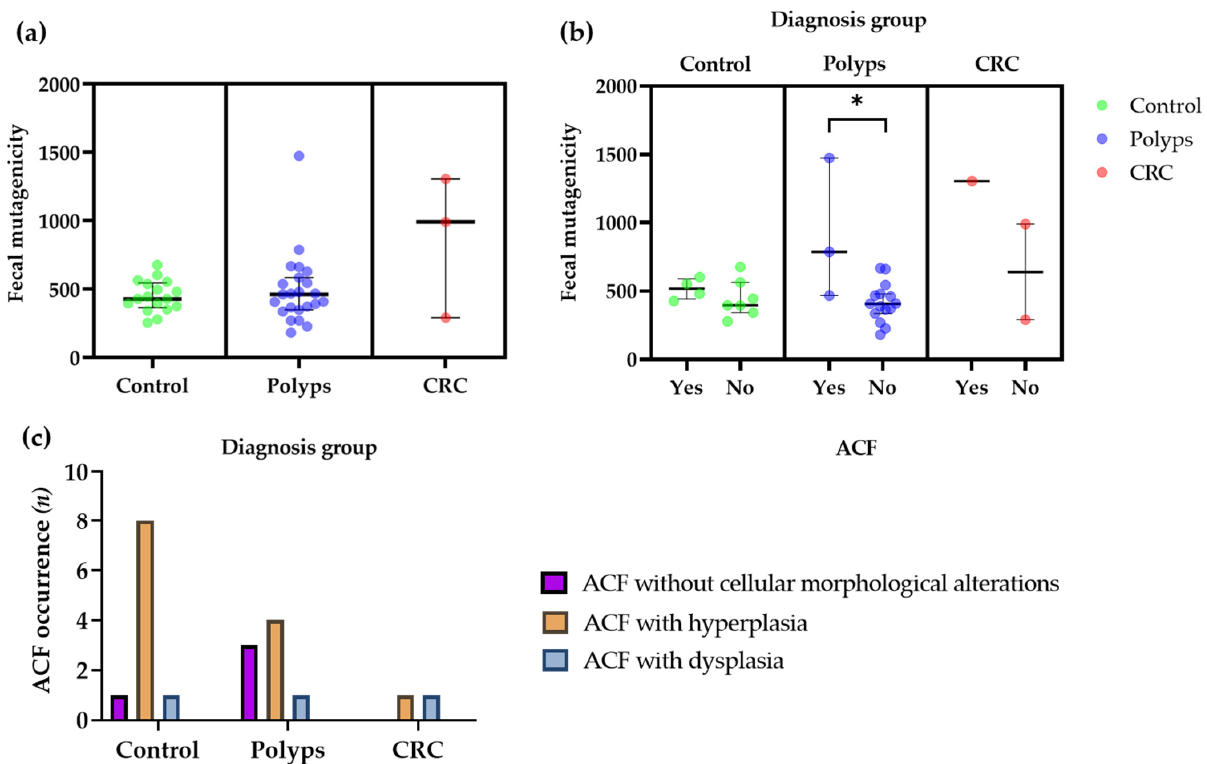
Figure 3. Dot plots comparing the mutagenicity of volunteers’ fecal samples according to ( a ) the clinical endoscopic diagnosis group and ( b ) the ACF occurrence. The fecal mutagenicity for each volunteer is represented by colored circles. Wide horizontal lines indicate the median for each condition and error bars represent the interquartile range or the range for the CRC group. (*) Significant differences between groups ( p ≤ 0.05). ( c ) ACF occurrence and type (hyperplastic, dysplastic, or without cellular morphological alterations) in the sample for each clinical endoscopic diagnosis group (control, polyps, and CRC). Each bar represents the number of cases detected for each ACF category in each diagnosis group. ACF, aberrant crypt foci; CRC, colorectal